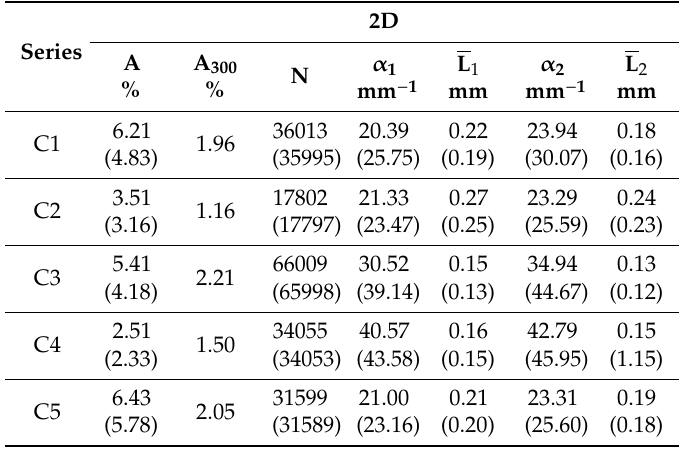
Table 3. Results of the air void parameter assessment with 2D procedure.